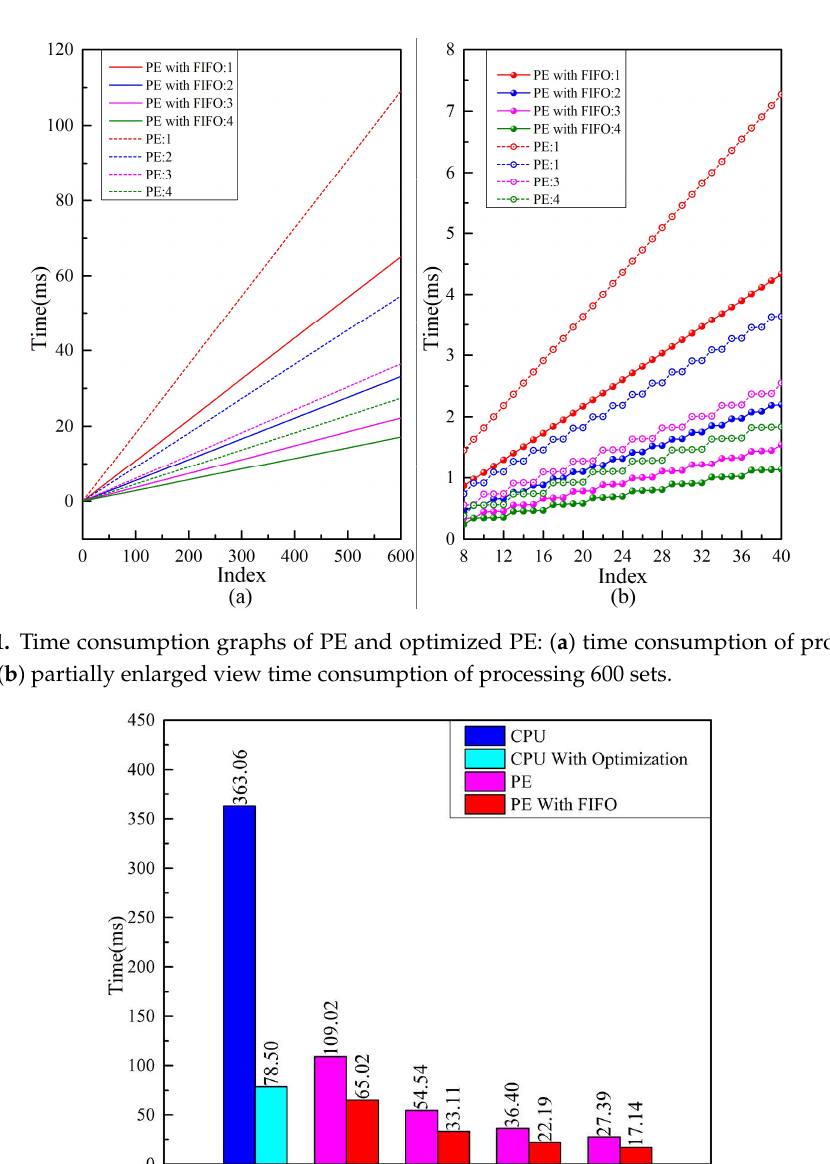
12 of 17 Figure 10. Time consumption graphs of CPU and PE: ( a ) time consumption of processing 600 sets; ( b ) partially enlarged view time consumption of processing 600 sets. As shown in Figure 10, compared with software process, the hardware process has a smaller slope regarding the time consumption of the matrix computing, and the total time consumption is considerably smaller. The processing method using multiple PEs in PL part, completing multiple sets of matrix operations simultaneously in parallel condition, reduces the time consumption and improves the computational efficiency. Therefore, multiple PEs achieve higher computational performance than the CPU in terms of matrix computing. Next, this study applies the optimized PE architecture.